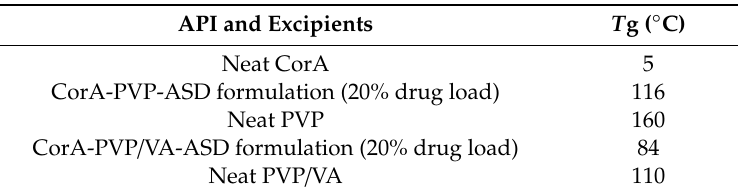
Table 3. Glass transition temperature ( T g) of the neat CorA, CorA-PVP-ASD and CorA-PVP / VA-ASD formulations, and the neat polymers PVP and PVP / VA.